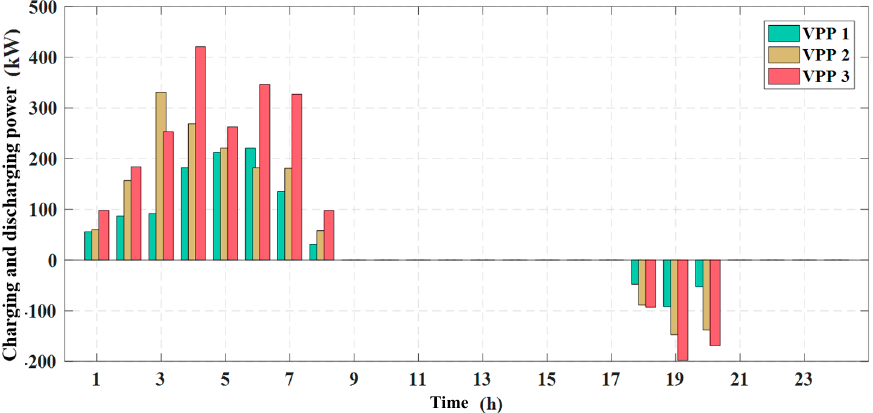
Figure 5. The charge–discharge power of EV agent.